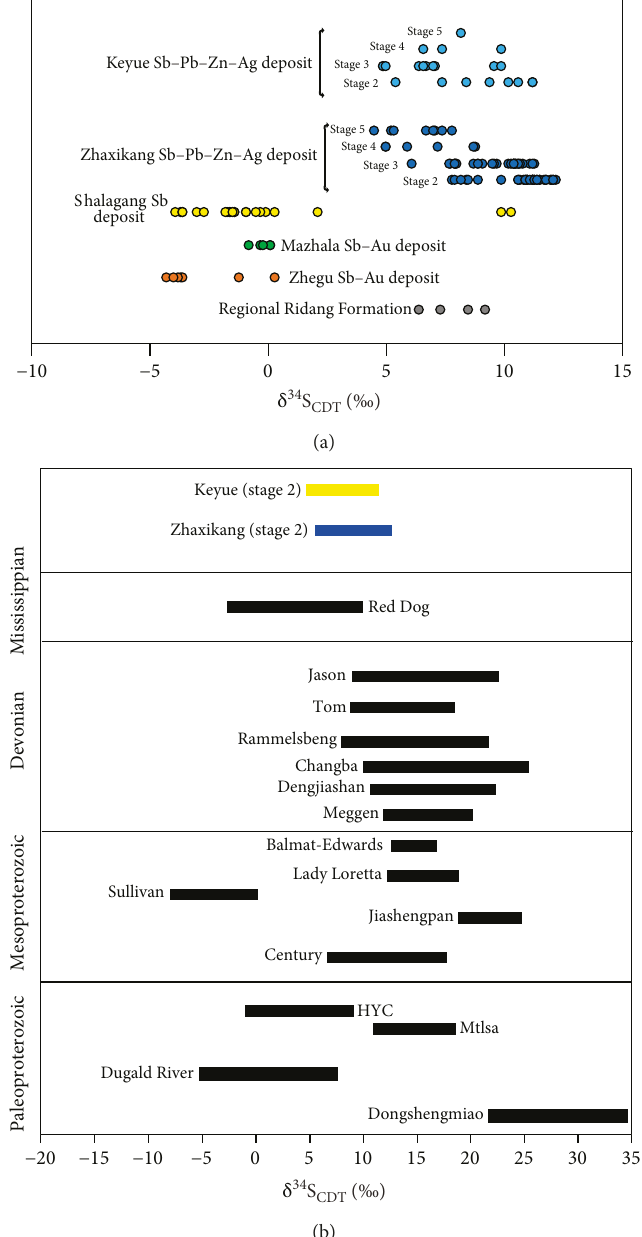
Figure 16: (a) The S isotopic compositions of sul fi de minerals from the Keyue Sb – Pb – Zn – Ag deposit, compared with Zhaxikang (data cited from Yang et al. [3], Sun et al. [9], Zhou et al. [18], and Zhang [73]), Shalagang, Mazhala, Zhegu, and Langkazi deposits (data cited from Yang et al. [1]) in NHMB. (b) The S isotopic compositions of stage 2 sul fi de minerals from the Keyue and Zhaxikang Sb – Pb – Zn – Ag deposits; the S isotopic compositions of sul fi de minerals from typical SEDEX deposits all over the world are also plotted for comparison (modi fi ed from Leach et al.